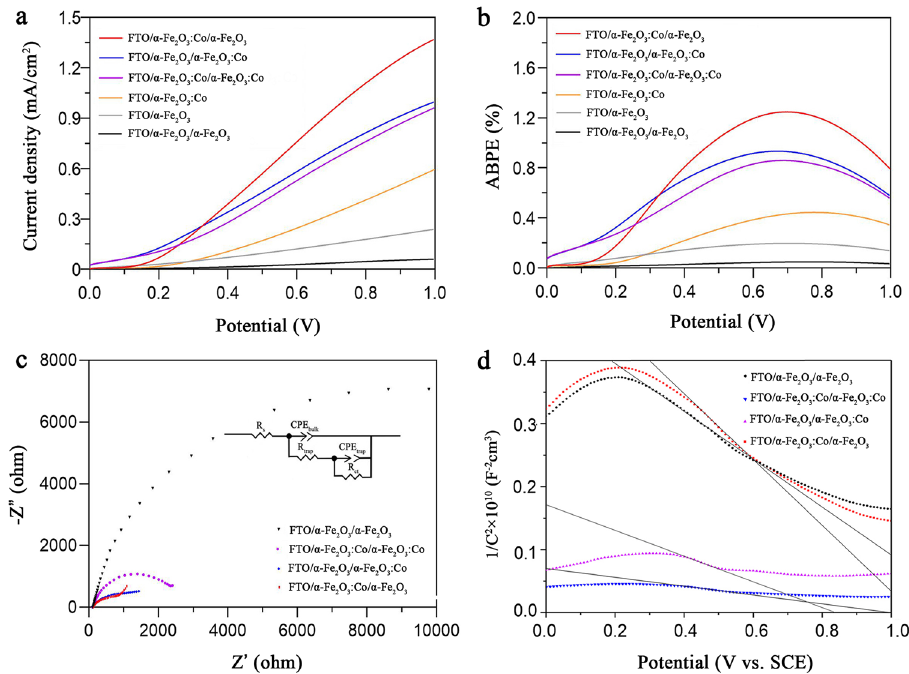
Fig. 4 a LSV, b ABPE, c Nyquist plots, and d Mott–Schottky of different